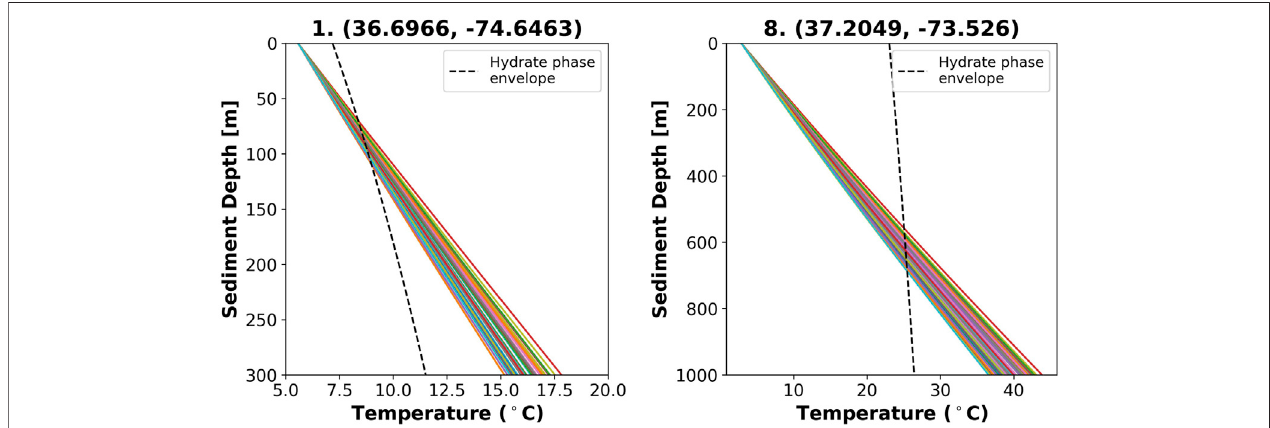
FIGURE7| TemperaturewithdepthatSite1(36.6966, − 74.6463)andSite8(37.2049, − 73.5260).Hydratesarestablewherethetemperaturepro fi leistotheleftof the hydrate phase envelope (black dashed line). Around 80 mbsf sediment depth at Site 1 (water depth 508 m), temperature pro fi les begin to cross the hydrate phase envelope, so hydrate is no longer stable. At the deeper Site 8 (water depth 2,595 m), temperature pro fi les begin to cross the hydrate phase envelope around 550 mbsf. Note the different depth scales between the two temperature pro fi les. This was done to better visualize the intersection of the phase envelope at Site 1.